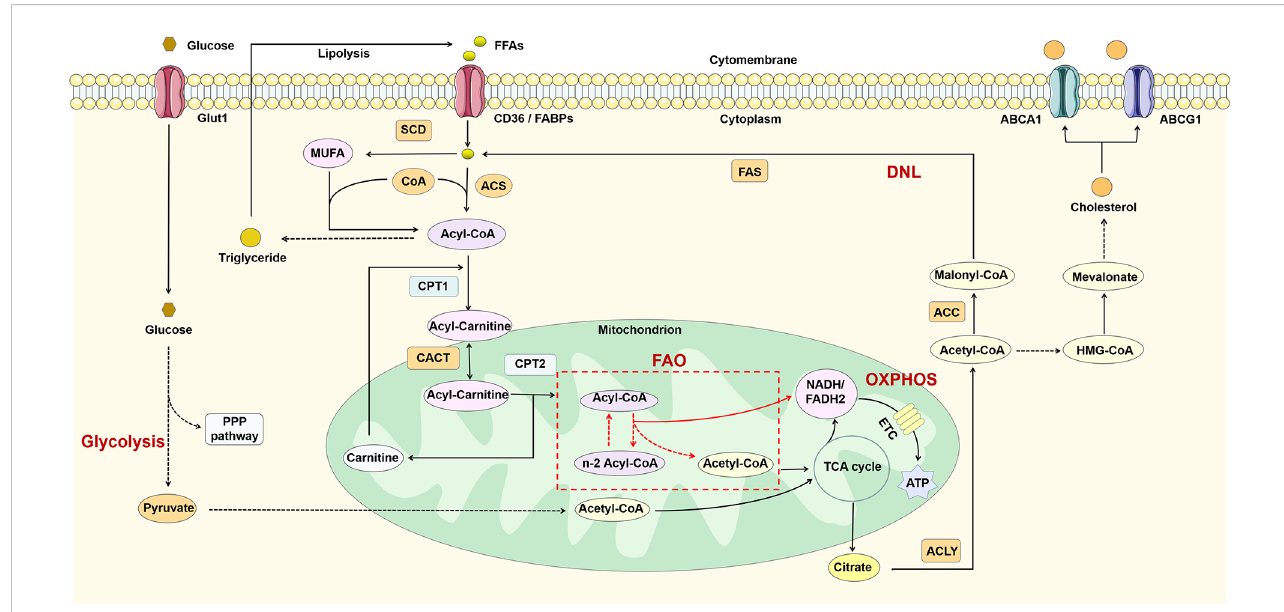
FIGURE 2 Lipid metabolism in macrophages. FFAs are catabolized to acyl-CoA by the action of ACS and thus participate in triglyceride synthesis and FAO. FAO can participate in the TCA cycle by producing acetyl-CoA and also promote OXPHOS by increasing NADH/FADH2 production. In addition, glucose can also produce acetyl-CoA through glycolysis. The citrate generated by the TCA cycle is reconverted to acetyl-CoA in the cytoplasm by ACL, thus participating in DNL and cholesterol synthesis. ABCA1, ATP-binding cassette sub-family A member 1; ABCG1, ATP-binding cassette sub-family G member 1; ACC, acetyl-CoA carboxylase; ACLY, ATP-citrate lyase; ACS, acyl-CoA synthetase; CACT, carnitine-acylcarnitine translocase; CoA, coenzyme A; CPT1, carnitine palmitoyl transferase 1; DNL, de novo lipogenesis; ETC, electron transport chain; FAO, fatty acid oxidation; FAS, fatty acid synthase; FFAs, free fatty acids; Glut1, glucose transporterisoform 1; MUFA, monounsaturated fatty acid; OXPHOS, oxidative phosphorylation; PPP pathway, pentose phosphate pathway; SCD, stearoyl-coenzyme A desaturase; TCA, tricarboxylic